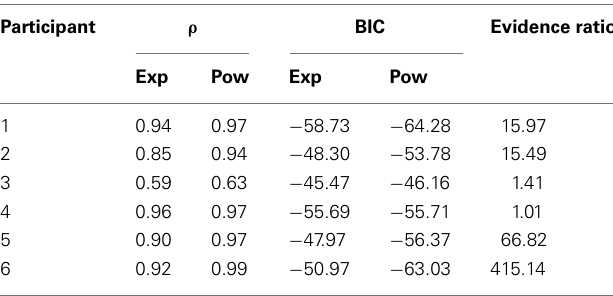
Table 5 | Correlation coefficient ( ρ ) and BIC values for the two-parameter power function and the exponential function for each participant.